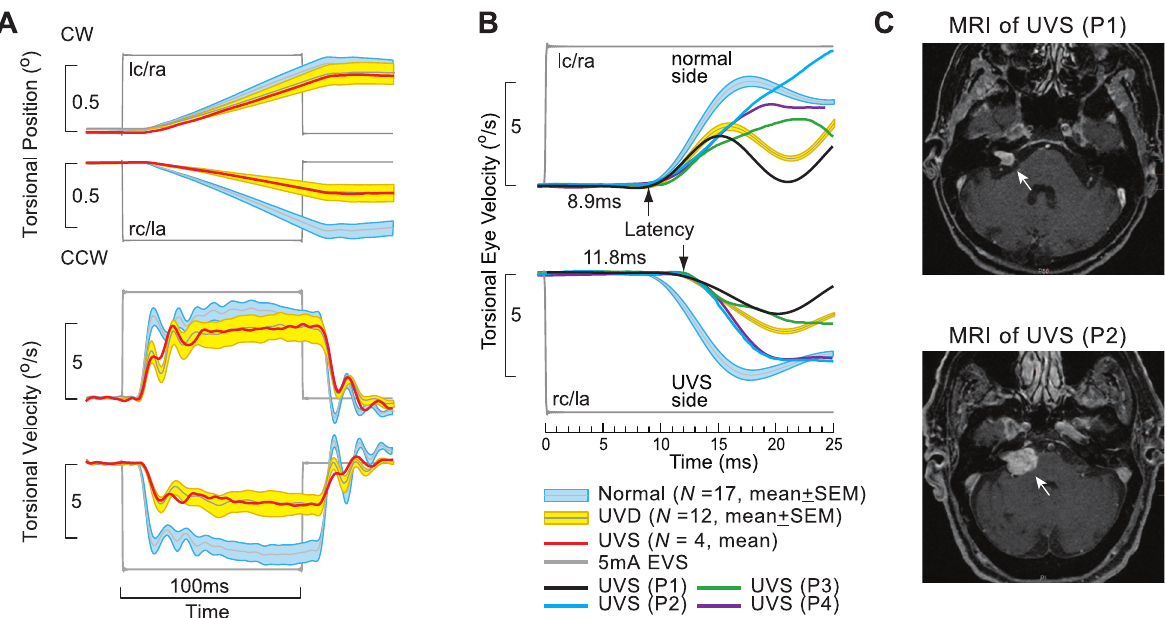
Figure 5. Comparison of the mean eVOR in UVS to normal and UVD subjects . (A) The mean eVOR in UVS ( N =4) was similar to UVD grouped as right lesions, but different from normal. Right UVS showed bidirectional, excitatory eVOR to 5 mA cathodal EVS and inhibitory eVOR to anodal EVS of the left ear at half the amplitude and opposite in direction, with excitatory-inhibitory asymmetrical response pattern similar to the right UVD. Mean latencies from 4 individual UVS patients (P1, P2, P3, P4) were compared to normal and right UVD subjects. (C) MRI from UVS patients (P1,